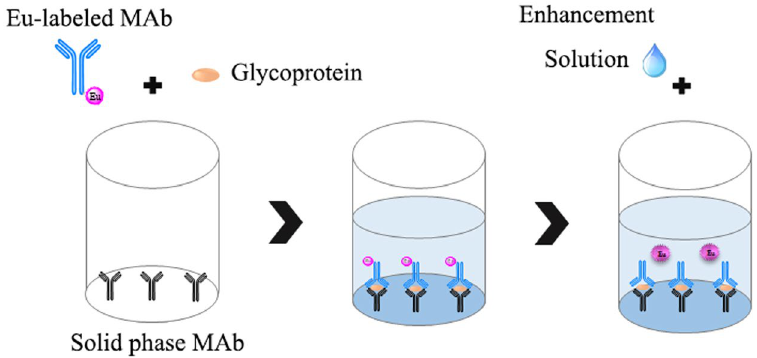
Figure 1. Example of the present TRFIA employing a europium chelate